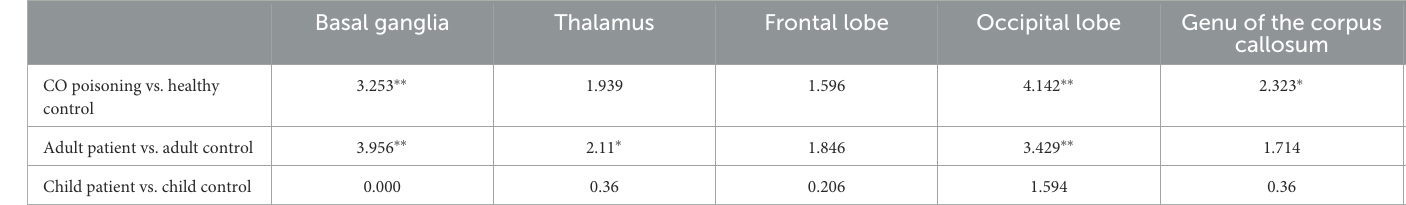
TABLE 3 Two-sample Mann–Whitney U- test in each